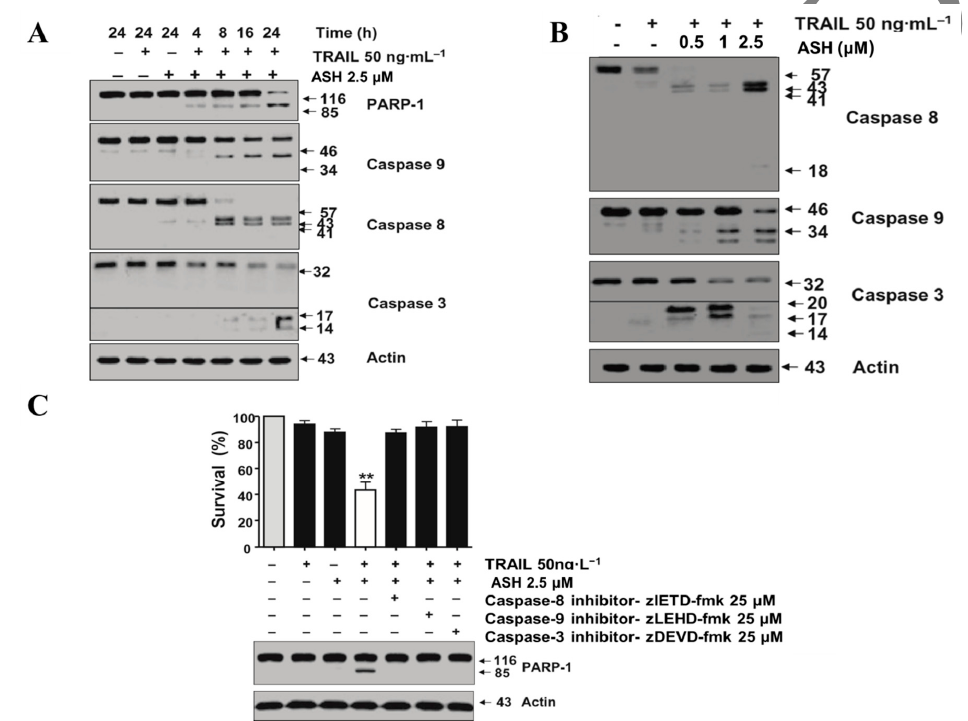
Figure 3. Combination therapy with ASH and TRAIL results in the activation of caspase in